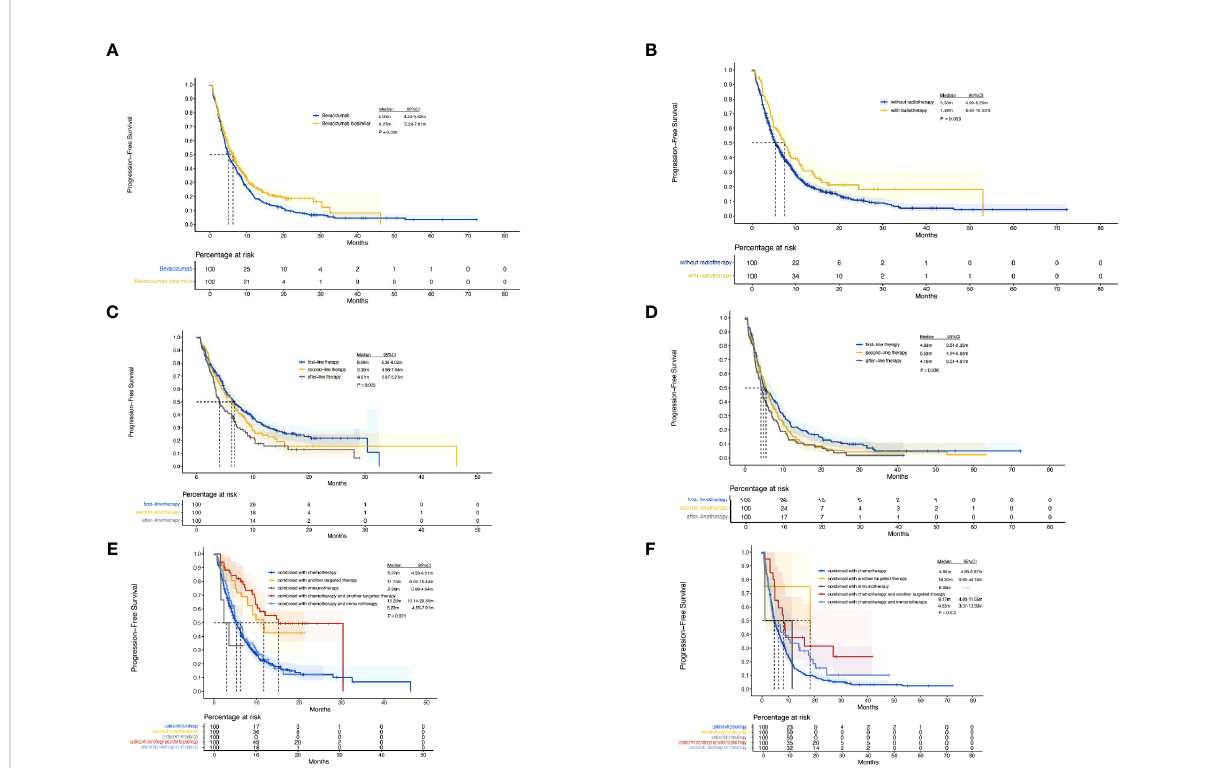
FIGURE 2 Kaplan – Meier curves. (A) , PFS of the biosimilar and reference groups. (B) , PFS of all the patients with or without radiotherapy. (C) , PFS of patients in the biosimilar group with different number of treatment lines. (D) , PFS of patients in the reference group with different number of treatment lines. (E) , PFS of patients in the biosimilar group with different combined treatment regimens. (F) , PFS of patients in the reference group with different combined treatment